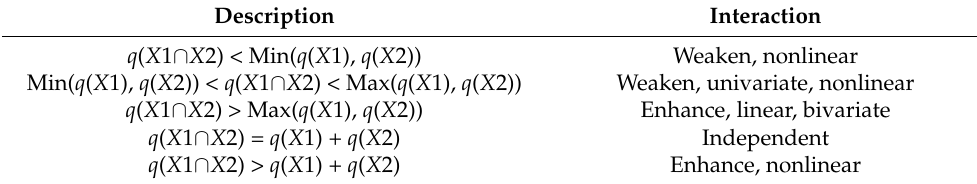
Table 4. Types of interaction between driving factors